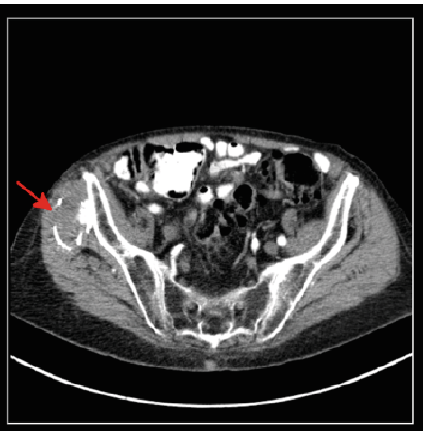
Figure 1: CT scan (axial view) of the patient ’ s abdomen and pelvis demonstrating radiopaque surgical material adjacent tothe right ilium.